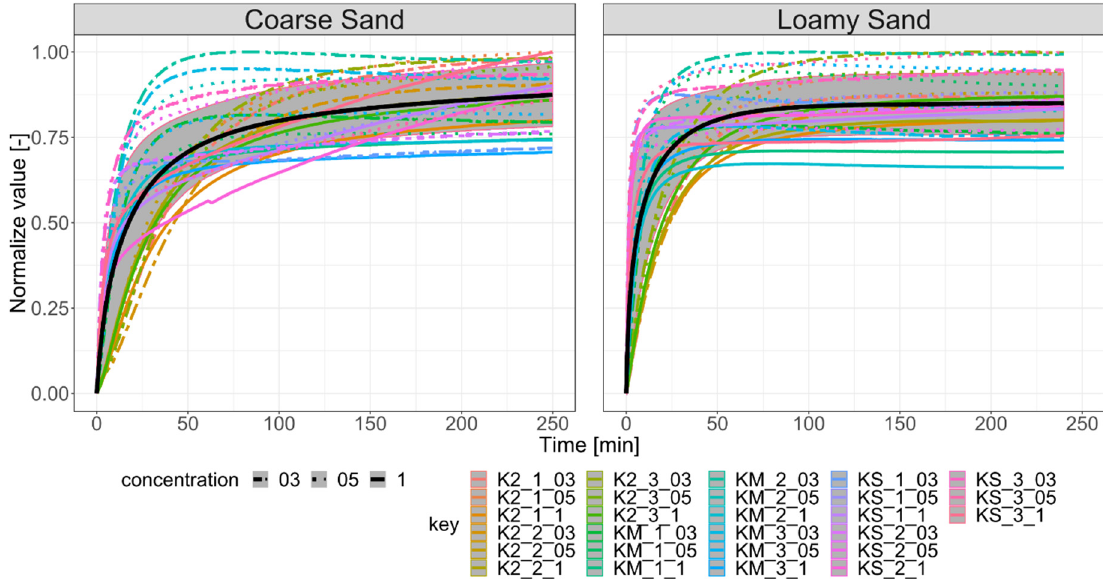
Figure 2. Normalized trajectories of experiments for coarse sand ( left ) and loamy sand ( right ) with the mean course and σ 1 range of acceptance.